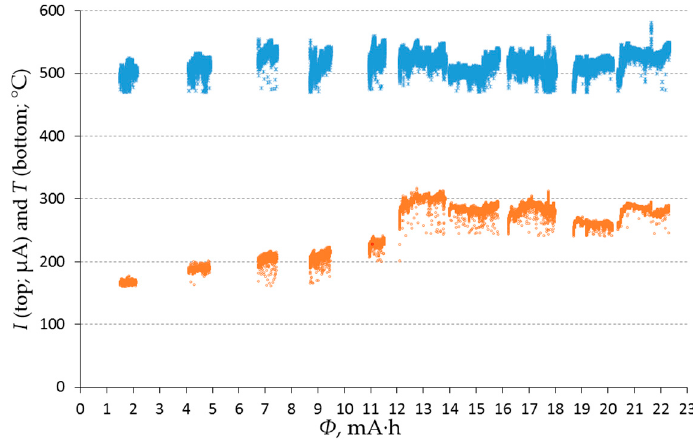
Figure 23. Dependence of the proton beam current I (top; μ A ) and pyrometer values T (bottom; °C ) on the accumulated integral of the current.